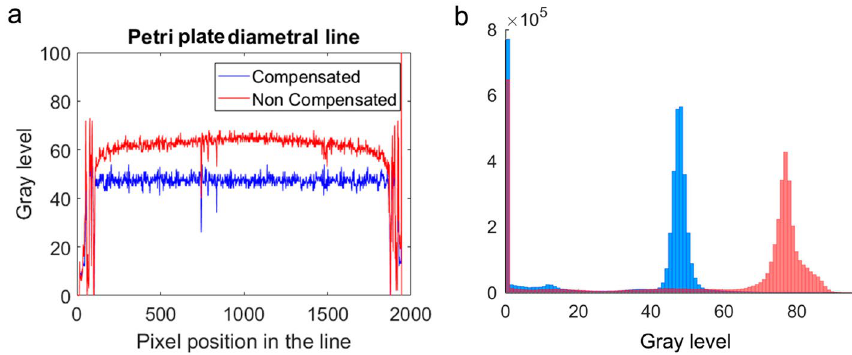
Figure 2. Light control results. The image was obtained with MATLAB R2020b. ( a ) Two images were taken of the same plate, one image was not compensated (red) while the other was compensated (blue). For comparison, the grey pixel level is shown in diametral line (profile line) to the Petri plate of each image. The diametral line measurements correspond to the intensity line profile. Compensated image tends to reference level (48). ( b ) The compensated image histogram shows the background level approximates the reference level